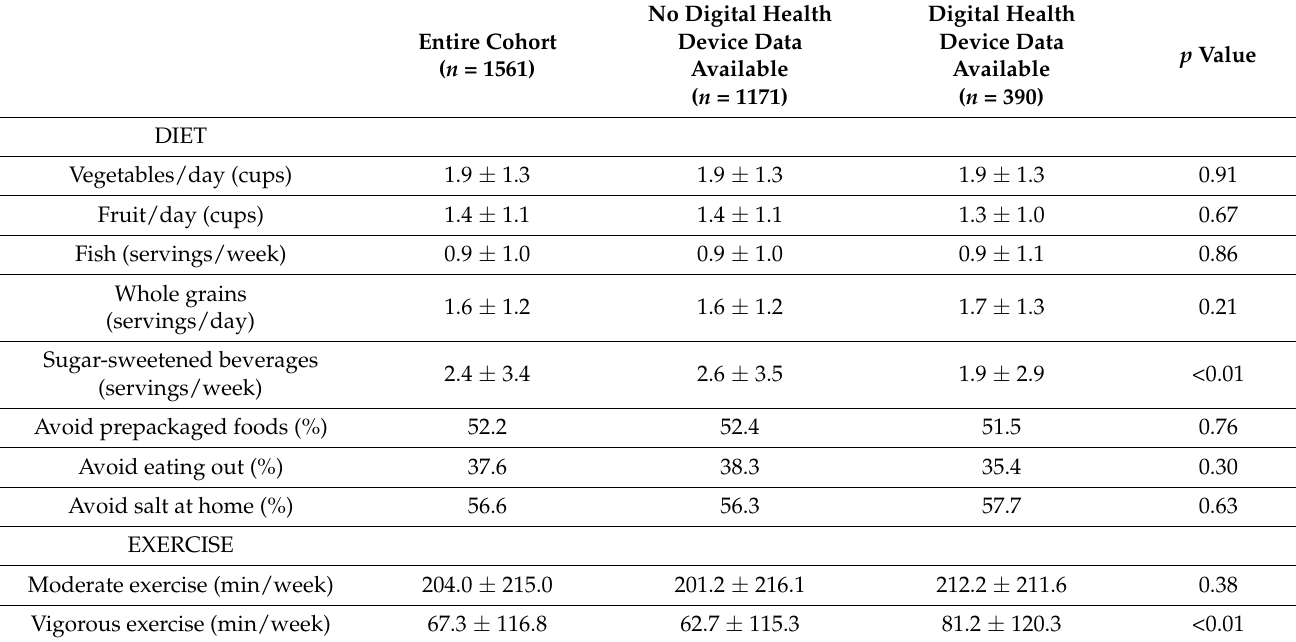
Table 2. Participant self-reported diet and exercise data.